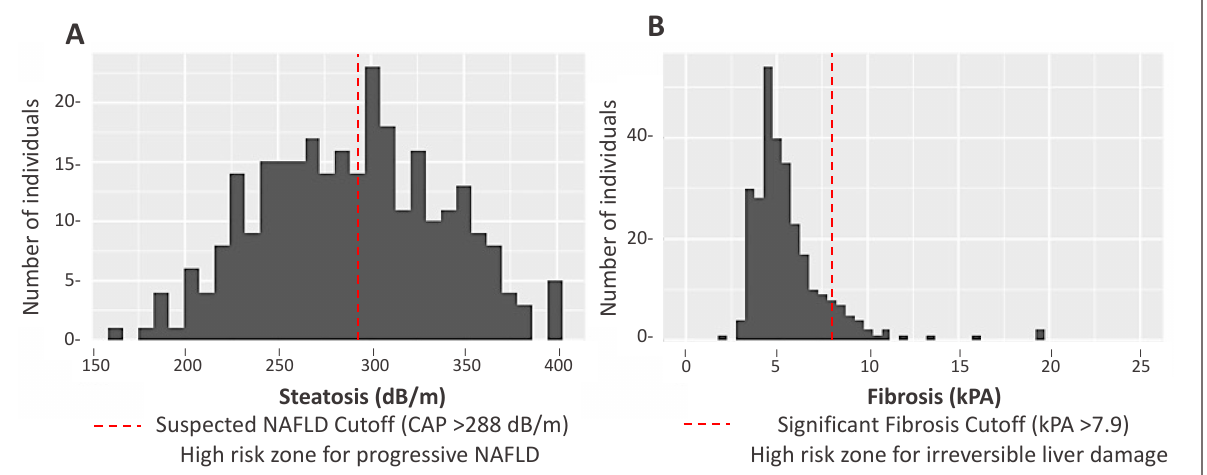
Figure 1. Distribution of steatosis and fibrosis scores as measured by transient elastography (FibroScan ® ) in a Mexican-origin Hispanic sample from Southern Arizona (N = 285). ( A ) Distribution of steatosis CAP scores (Mean: 289.5 dB/m, Standard Deviation [SD]: 48.9 dB/m). ( B ) Distribution of liver fibrosis values (Mean: 55.67 kPA, SD: 2.83 kPa).